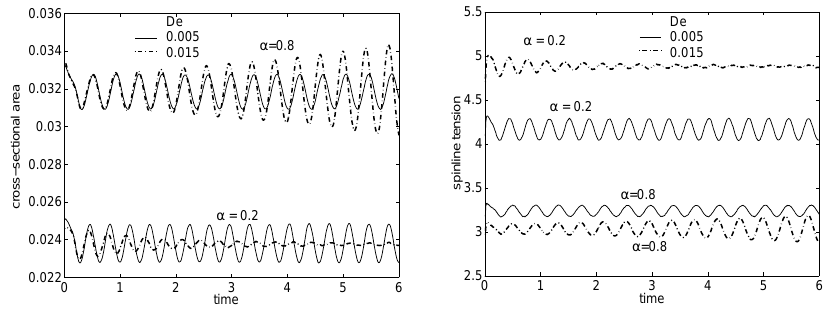
Figure 2. Transient response of the cross sectional area (left) and spinline tension (right) at take-up for extension thickening fluids ( α = 0 . 2 ,D = 40 ) and extension thinning fluids ( α = 0 . 8 ,D = 30